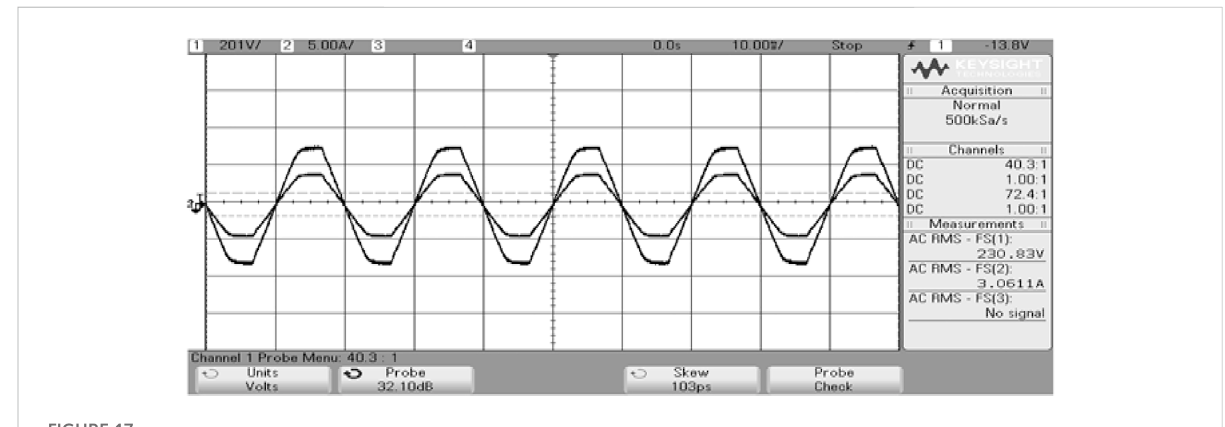
FIGURE 17 Three-phase voltage and